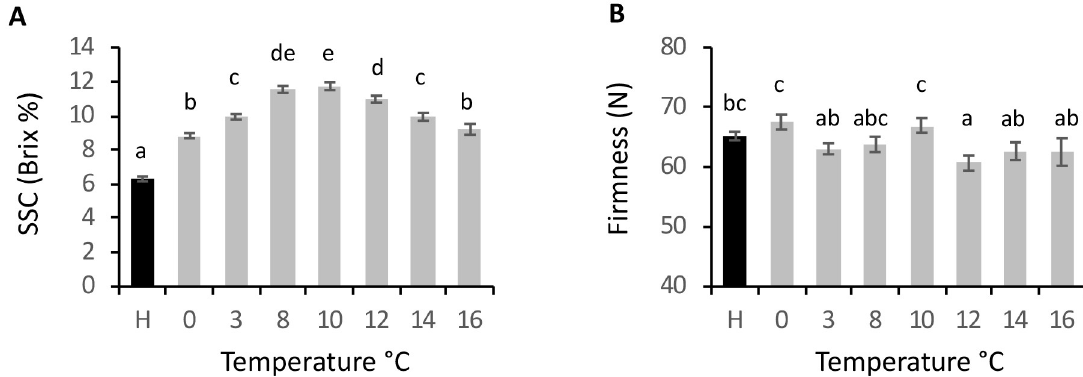
Fig 2. Fruit physiology. A. Soluble solids content (SSC) and B. firmness of Actinidia chinensis var. chinensis ‘Hort16A’ kiwifruit at harvest (AH) and after 8 days at temperatures between 0 and 16˚C. n = 20, ± s.e.m. letters represent significance p < 0.05.